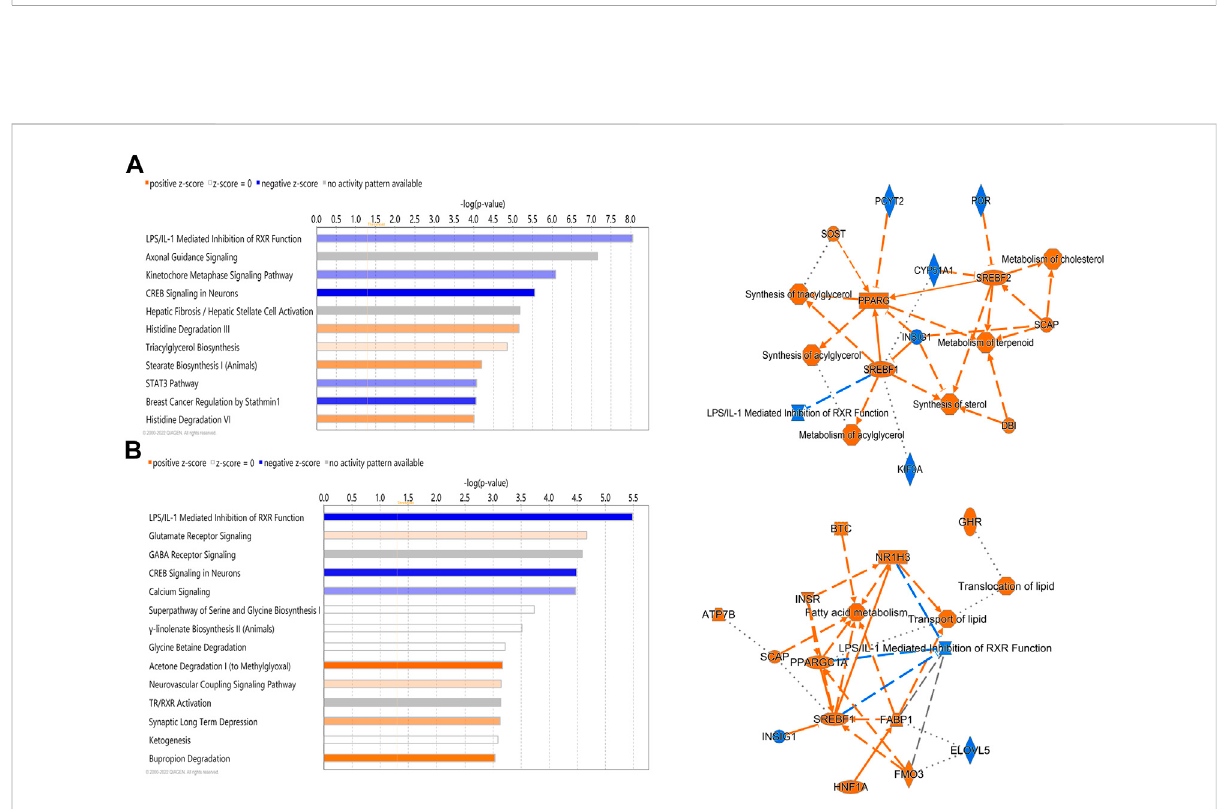
FIGURE 6 Canonical pathways of differentially expressed hepatic genes between DLY chicks and E18 embryos. (A) Genes with a fold-change ≥ 2; FDR p -value ≤ 0.05and (B) Geneswithafold-change ≥ 5;FDR p -value ≤ 0.05.Orangeindicatesapositivez-score;expressionpatternsofmemberspredicts activation of the pathway. Blue indicates a negative z-score; expression patterns of members predicts inhibition of the